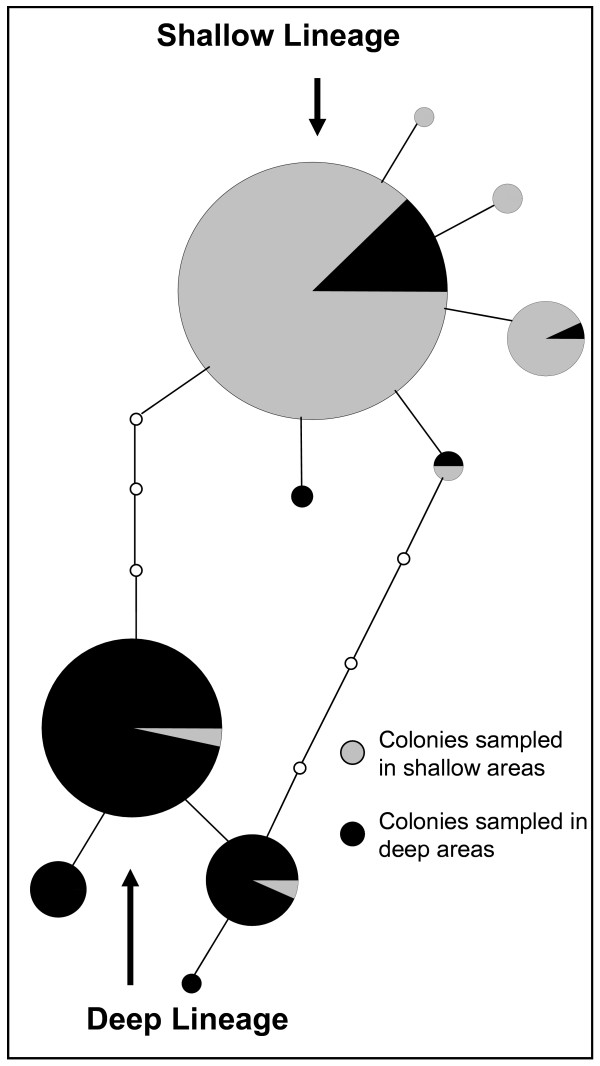
Parsimony haplotype networks based on msh1 for colonies inhabiting shallow or deep areas. The network indicates the six haplotypes found in shallow areas (i.e., shallow type) and the four haplotypes found in the deep areas (i.e., deeptype). The size of the circle is proportional to the observed number of sequences for the corresponding haplotype. The minimum number of steps is represented by the small empty circles.